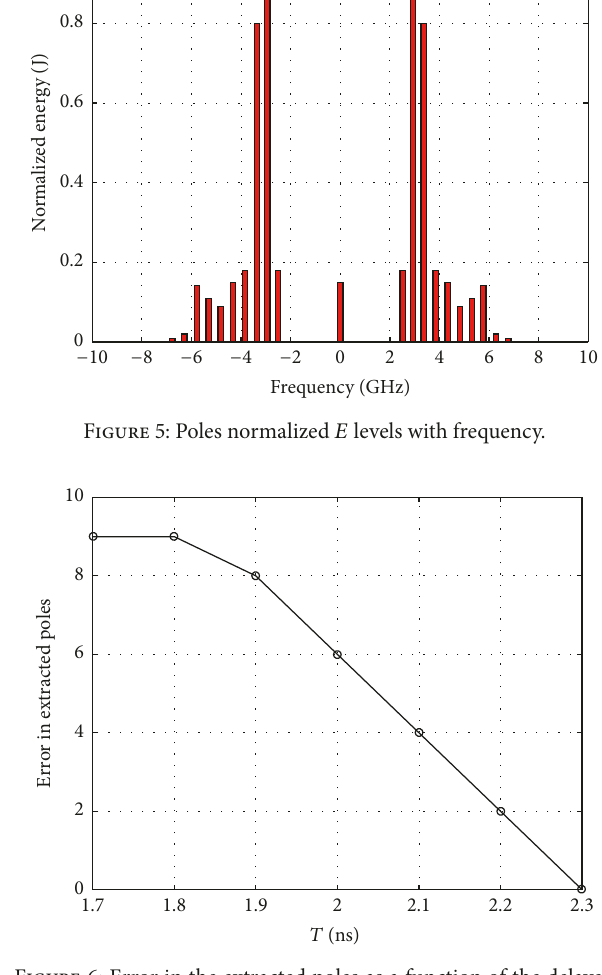
Figure 6: Error in the extracted poles as a function of the delayed time parameter T.